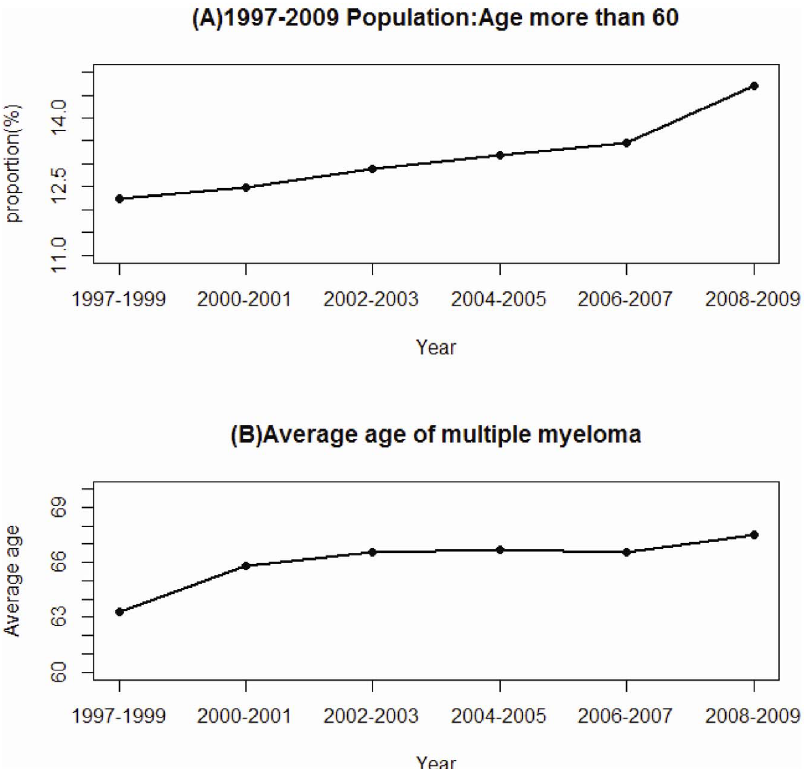
Figure 1. Proportion of insured population aged . 60 years measured chronologically (A), and mean ages of patients with newly diagnosed multiple myeloma (B) for the period of 1997–2009.